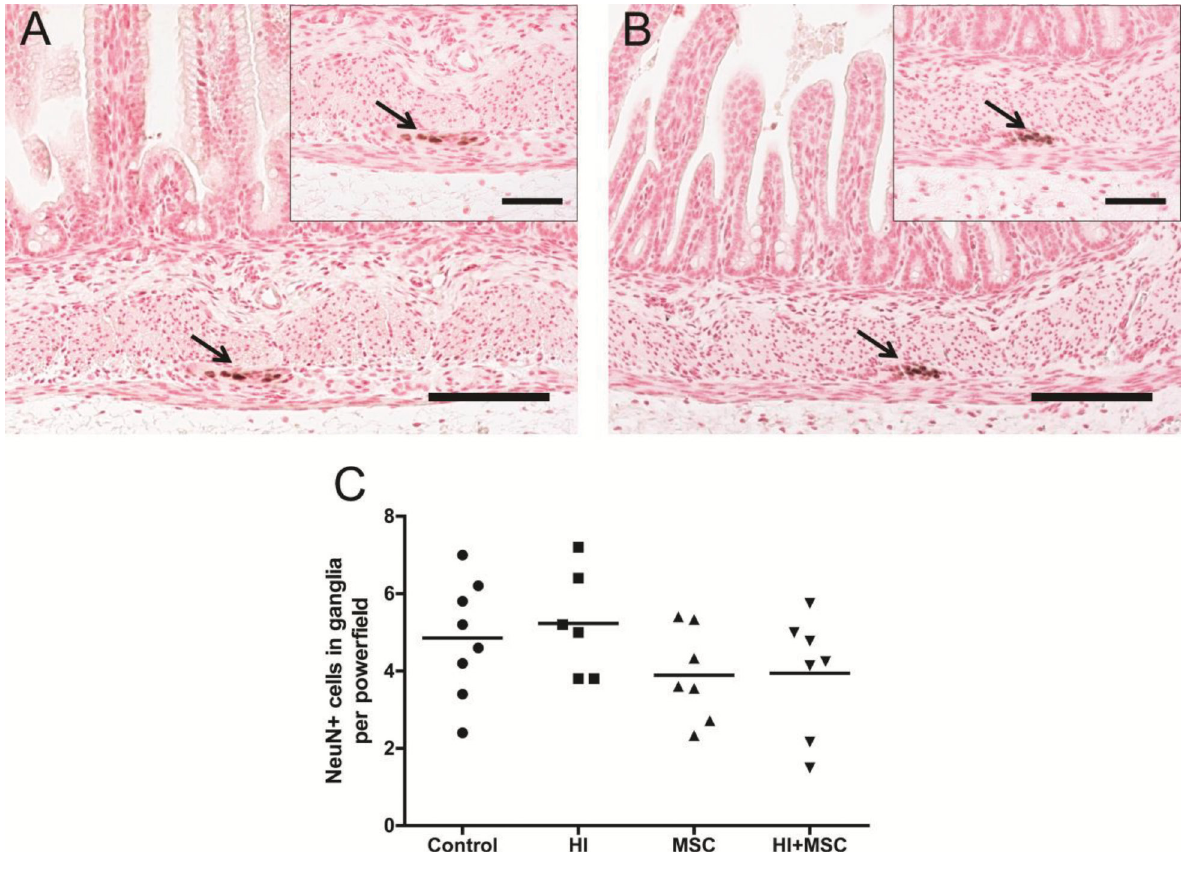
figure 7. Number of NeuN + cells in myenteric plexus 7 d after HI. Representative gut sections of (A) control and (B) HI animals were stained by NeuN, a marker for neuronal nuclei. The number of NeuN + cells (arrows) in myenteric ganglia remained at baseline level (C). The scale bar in panels A and B represents 100 μ m. The scale bar in insets represents 50 μ